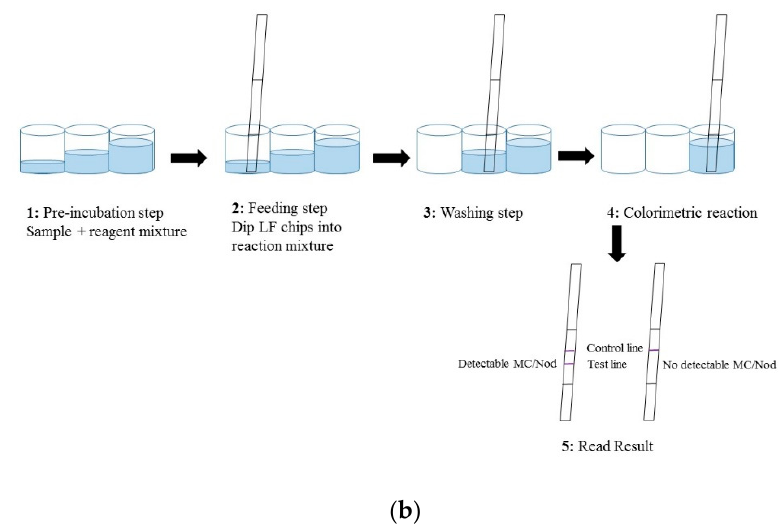
Figure 1. ( a ) Conceptual illustration of the noncompetitive chromogenic LFIA. Top: The structure of the LFIA strip comprising feeding pad, nitrocellulose membrane, and absorbtion pad. Test line (HAMA: human anti-mouse antibody) and control line (anti-AP Pab) were printed on nitrocellulose membrane. Bottom: Principle of the chromogenic anti-IC LFIA. The sample absorbing procedure was performed on microtiter well. Once the liquid is absorbed, the reagents move along the immunostrip by capillary action and respective antibody components attach to the test and control lines. In the presence of MC/Nod in the sample the anti-Adda Mab:MC/Nod:anti-IC-scFv-AP complex become captured by HAMA on the test line through the Fc portion of the anti-Adda Mab. The excess unbound anti-IC-scFv-AP continue to migrate until captured by the anti-AP Pab in the control line. The alkaline phosphatase (AP) fused with the anti-IC scFv triggers an enzymatic reaction producing a chromogenic precipitant in the presence of BCIP/NBT substrate. In the absence of MC/Nod, anti-IC scFv-AP does not bind to the test line and continue to migrate until captured in the control line. The control line ensures that the chromogenic reaction is functional in the LFIA. ( b ) The main steps of the LFIA procedure where the sample absorption took place on microtiter well. The assay protocol comprised of four main steps. (1) In the preincubation step, sample and reagents are mixed together to allow formation of the anti-Adda Mab:MC/Nod:anti-IC-scFv-AP complex in the presence of toxin. (2) In the feeding step, LF chips were dipped into the pre-incubated reaction mixture through feeding pad where antibody components or any formed immunocomplex migrated through test and control line. (3) The washing step removes any unbound antibody components. (4) In the fourth step, colorimetric reaction took place in the presence of chromogenic substrate. (5) Finally, the developed color on the strips can be observed by naked eye or through instrument (optional). MC = microcystin; Nod = nodularin.